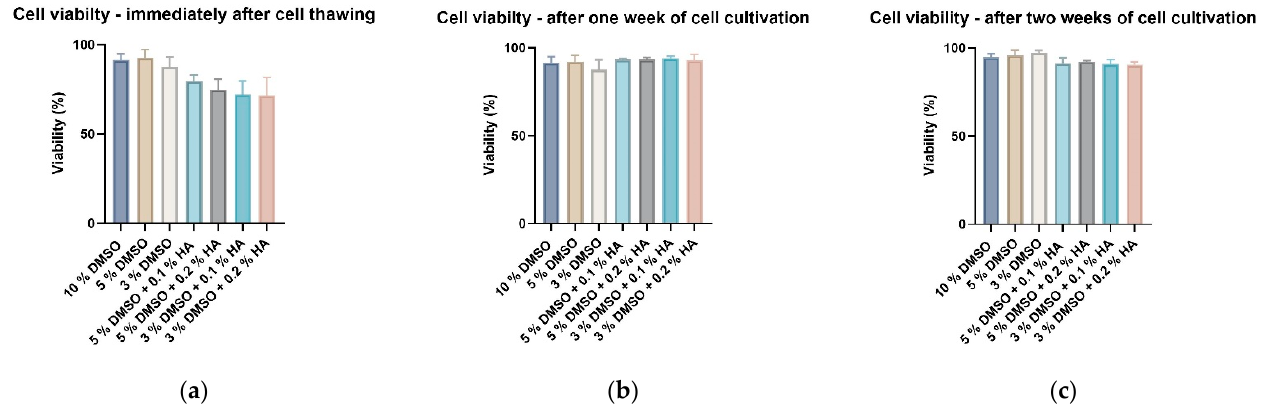
Figure 3. Viability of DPSCs measured using trypan blue exclusion method and the Vi-Cell analyzer (Beckman Coulter): ( a ) immediately after thawing; ( b ) after one week of cell cultivation; ( c ) after two weeks of cell cultivation. Data are presented as a mean and SD plotted as error bars. The statistical analysis was performed between control and experimental groups using Friedman’s test followed by Dunn’s multiple comparison test.